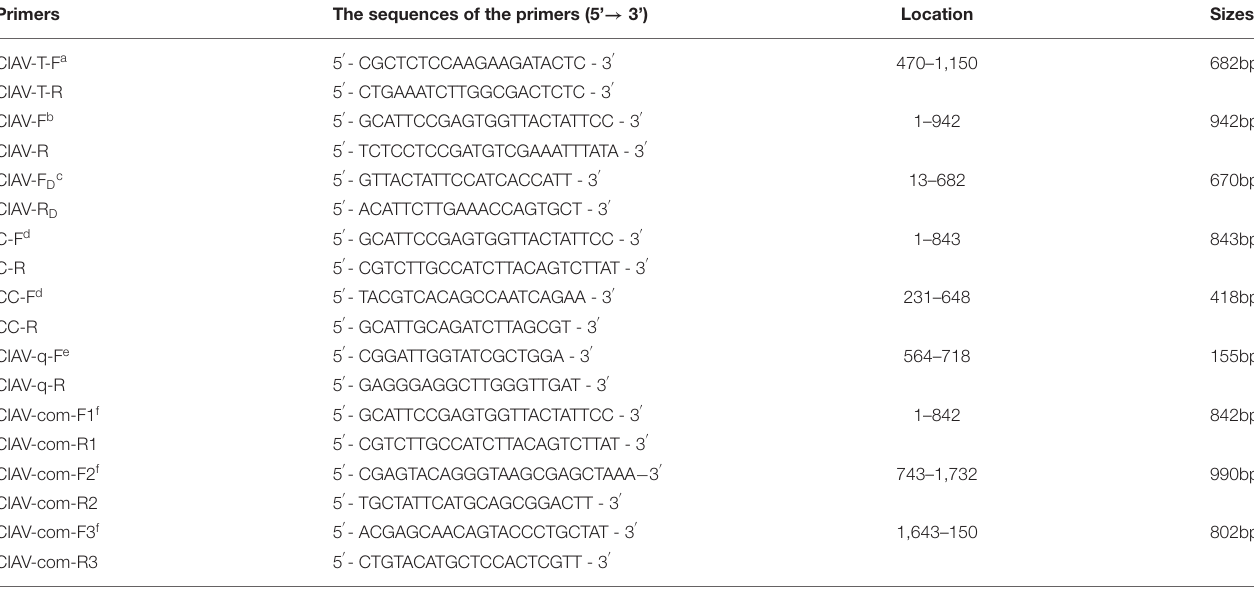
TABLE 2 | Sequences of primers used for amplification in this study.